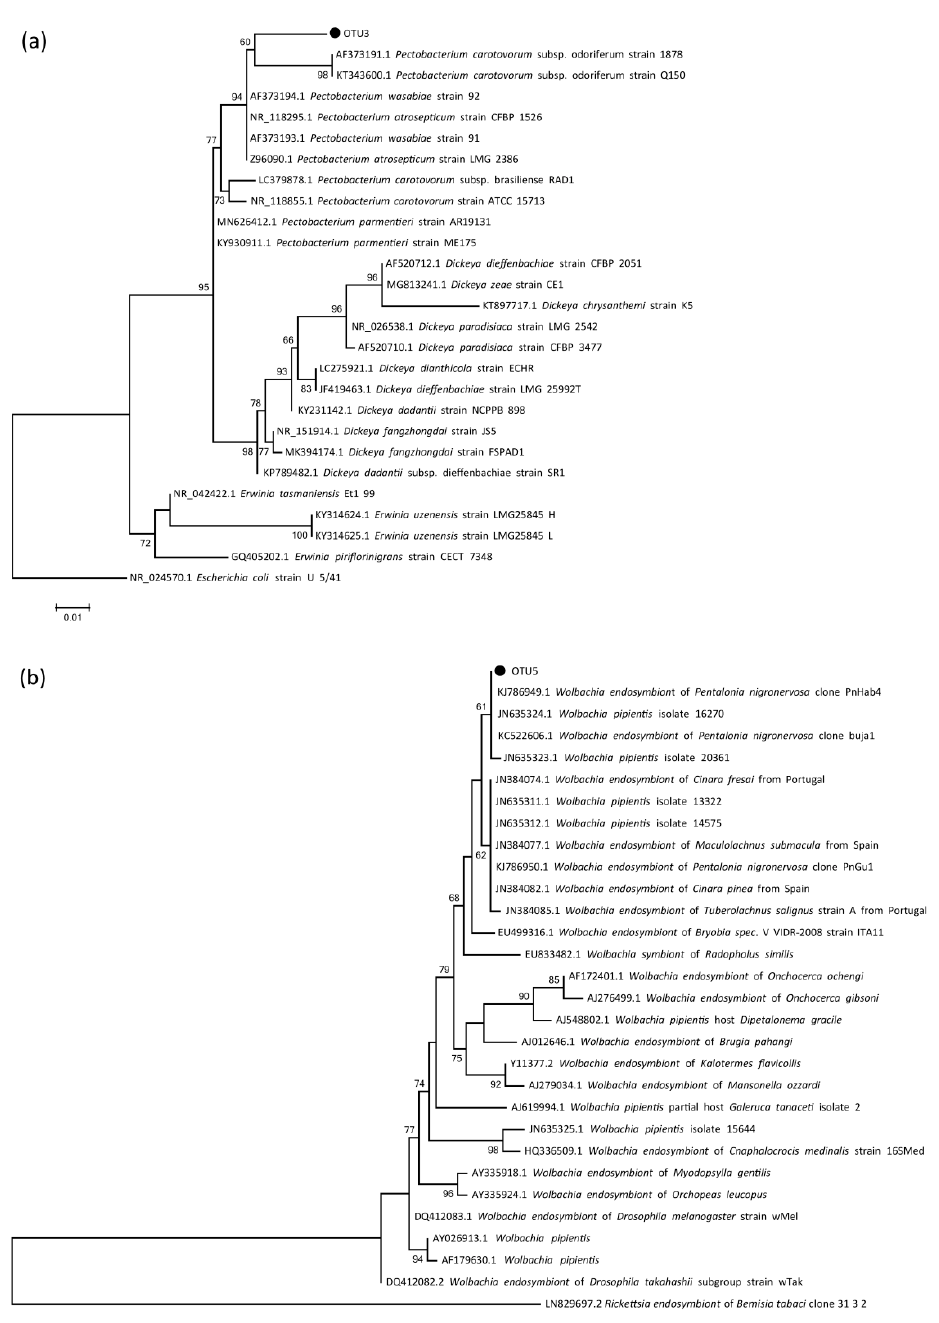
Figure 2. The maximum likelihood phylogenic tree of ( a ) Pectobacterium and ( b ) Wolbachia based on 16s rDNA V3–V4 region. OTU3 and OTU5 represent the main OTU of Pectobacterium and Wolbachia from all Pseudoregma bambucicola samples, respectively. Numbers above the branches indicate the bootstrap support values, for which lower than 50 are not